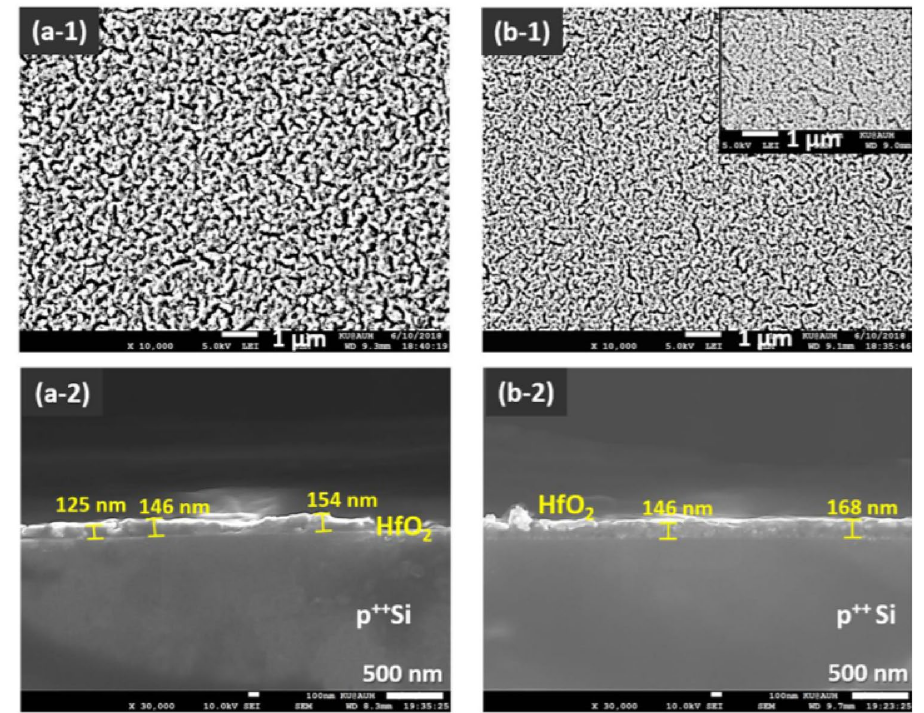
Figure 4. SEM images of the top views ( a-1 , b-1 ) and cross-section views ( a-2 , b-2 ) of HfO2/p++ Si regions from wafer samples A1 and A2, successively spin coated at a speed of 2000 RPM, using the same composite precursor mixture at room temperature. ( a-1 , a-2 ) sample A1; ( b-1 , b-2 ) sample A2. The inset in b-1 displays another top view area of sample A2. The results show a denser surface texture of the oxide layer in sample A2 ( b-1 ), implying a solution-aging factor. We can add the previous data to the paper if this is